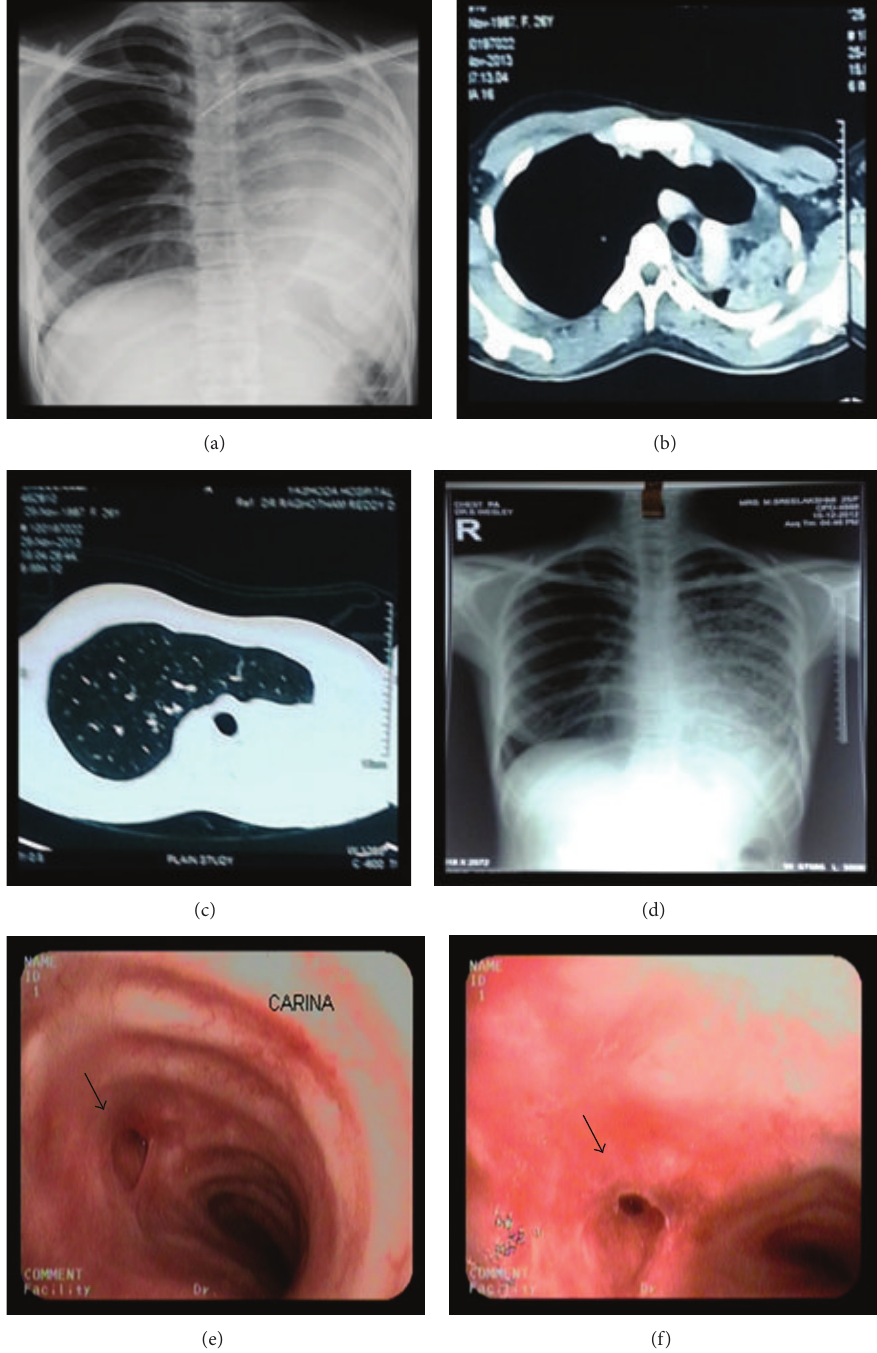
Figure 2: (a), (b), and (c) Chest X ray and CT at presentation showing left lung collapse with mediastinal shift and compensatory hyperinflation of the right lung. (d) Pretreatment chest X ray showing extensive left sided miliary nodules. (e) and (f) Bronchoscopic appearance of pinhole sized left main bronchial opening